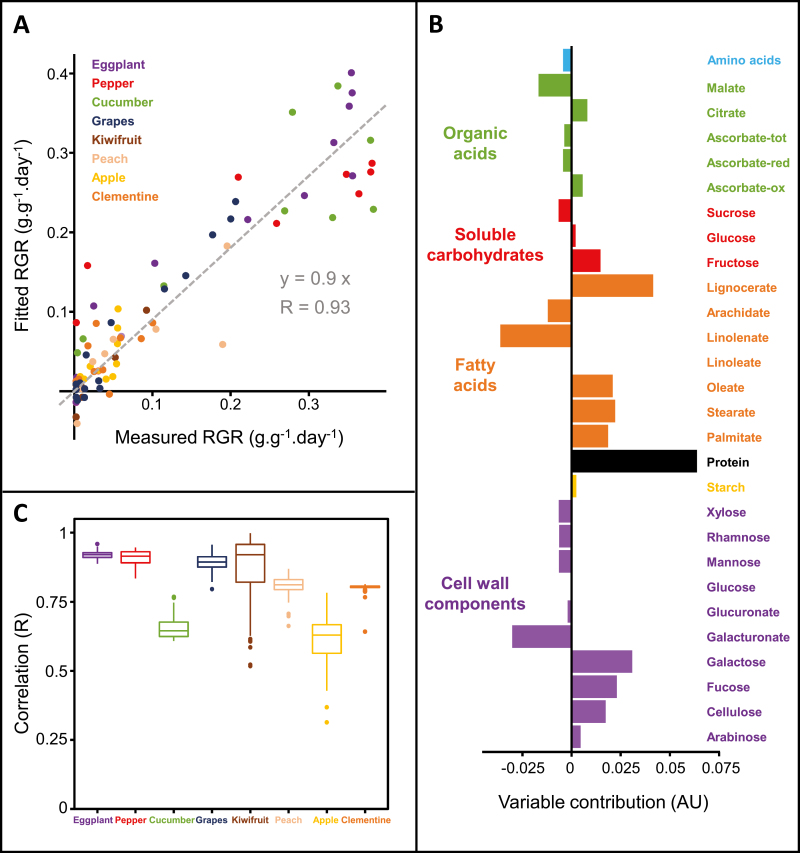
Generalized linear modelling for the prediction of relative growth rate (RGR) from contents of 28 compounds quantified in eight fruit species and at all developmental stages. (A) Correlation graph between RGR values measured and calculated by a model for all fruits from concentrations expressed per g dry matter. (B) Importance of the contribution of variables classified by biochemical family for the linear model. (C) Box plot representing the distribution of correlation coefficients (n=100) obtained for each fruit species by using models constructed with data obtained from the other seven species.